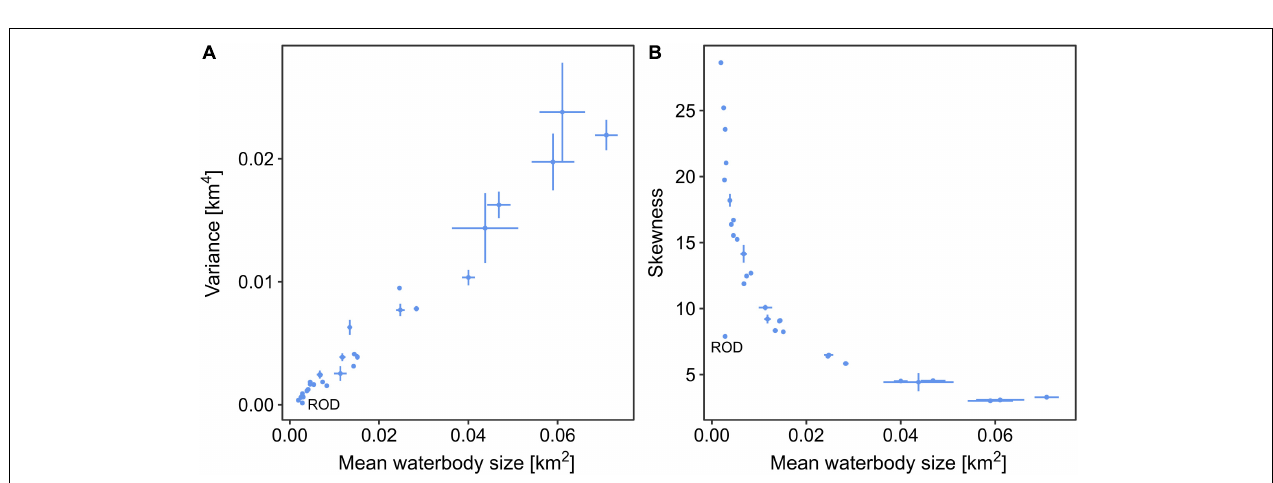
FIGURE 4 | (A–C) A cumulative histogram or rank/frequency plot of waterbody sizes in the thirty study regions (split into three groups). Dotted lines indicate the lower and upper size limits used for the analysis (0.0001 and 1 km 2 , respectively). Study regions are sorted according to their mean waterbodies size (within the band limit). Both the x and y axes are plotted on logarithmic scales. For study region numbers see Figure 1 and Supplementary Table 1 .